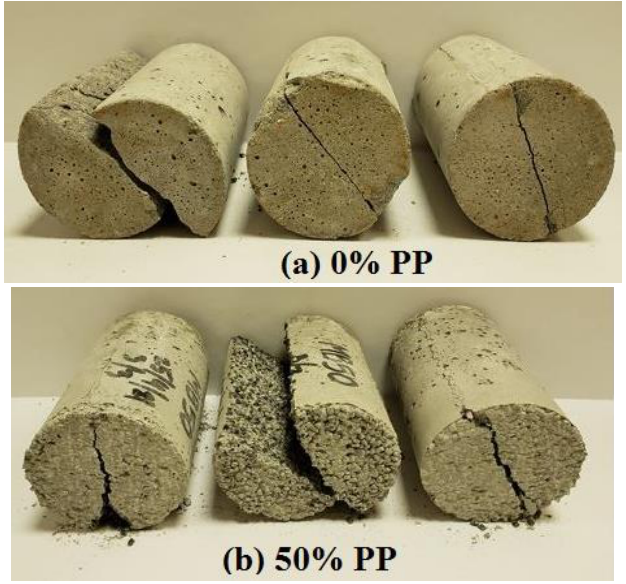
Figure 9. Effect of PP content on failure mode of tested specimens under splitting tensile load: ( a ) 0% PP ( b ) 50% PP.